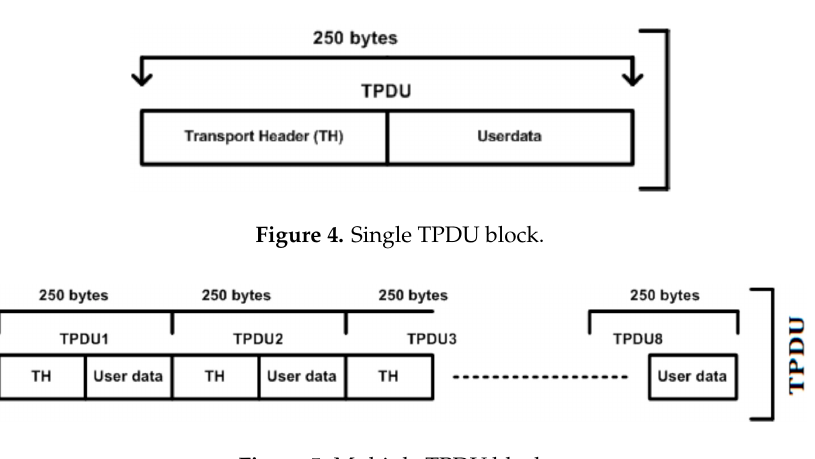
Figure 3. Simulation design and environment.